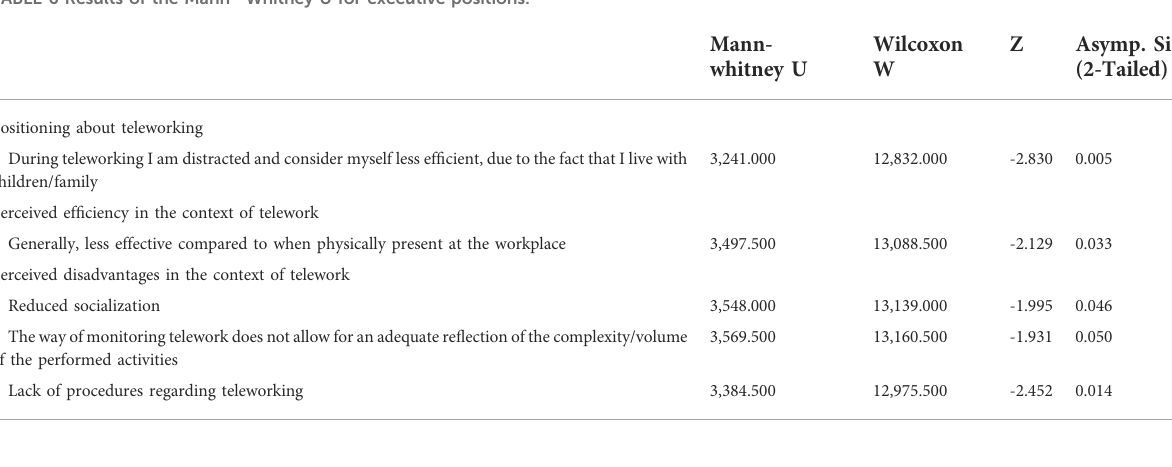
TABLE 6 Results of the Mann — Whitney U for executive positions.